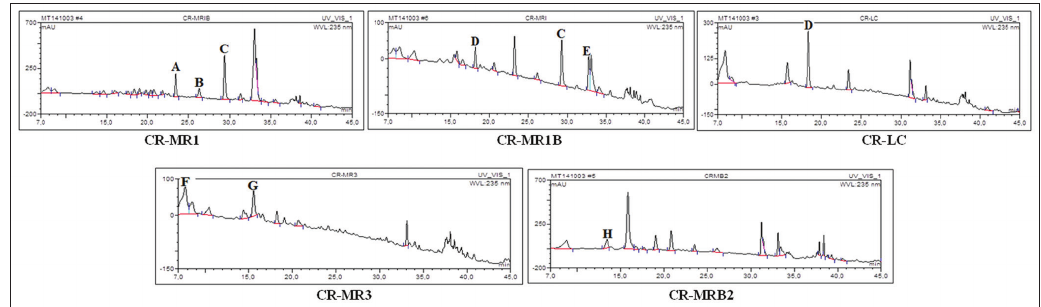
FIGURE 1. HPLC chromatograms showing the detection of, (A) Citreoisocoumarin, (B) Citreoisocoumarinol, (C) Questinol, (D) Acropyrone, (E) Hydroxyemodin, (F) Methyl 2‑(4‑hydroxyphenyl) acetate, (G) Nigricinol and Cladosporin in the fungal extracts.